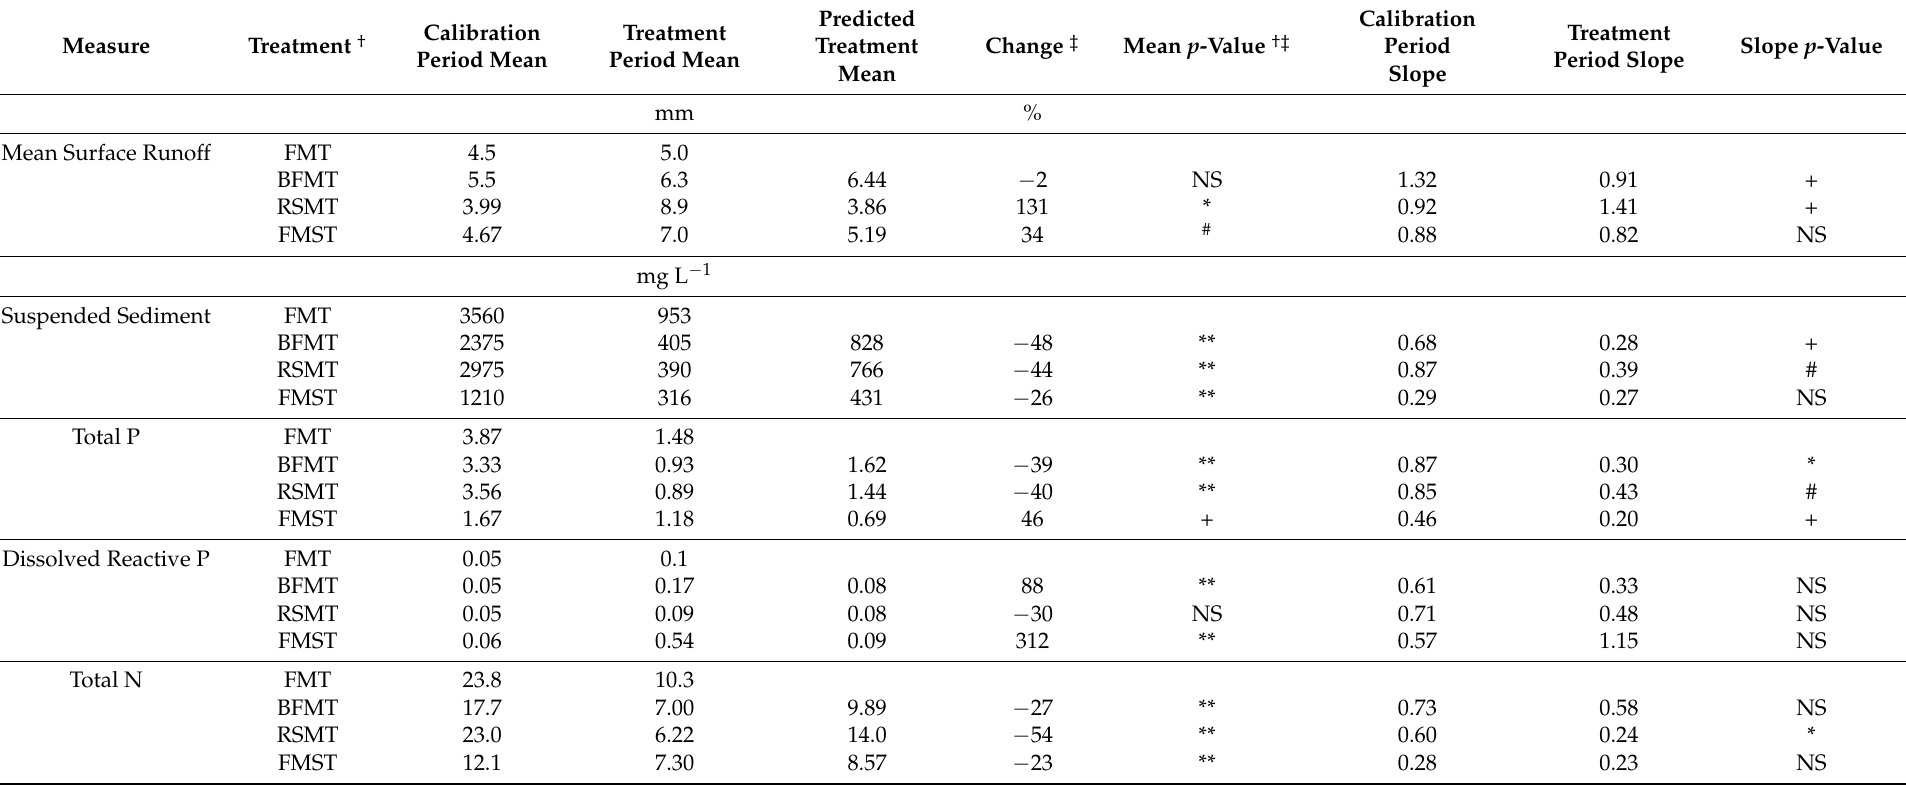
Table 3. Event-based means and regression slopes for calibration and treatment periods, predicted treatment periods means, and hypothesis test results for runoff volume, suspended sediment, and nutrient